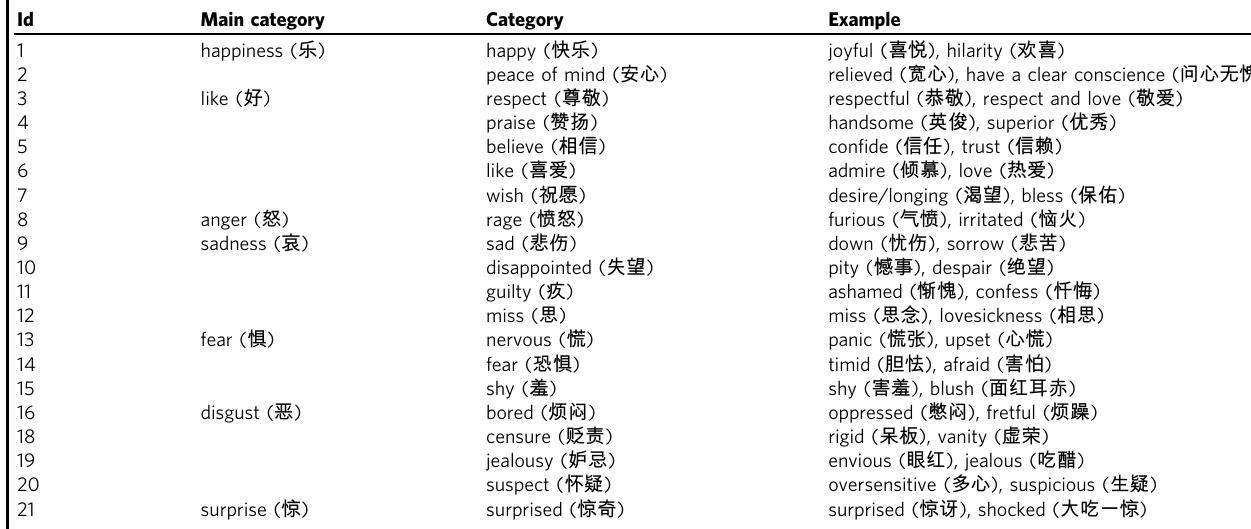
Table 1 Examples of emotion ontology